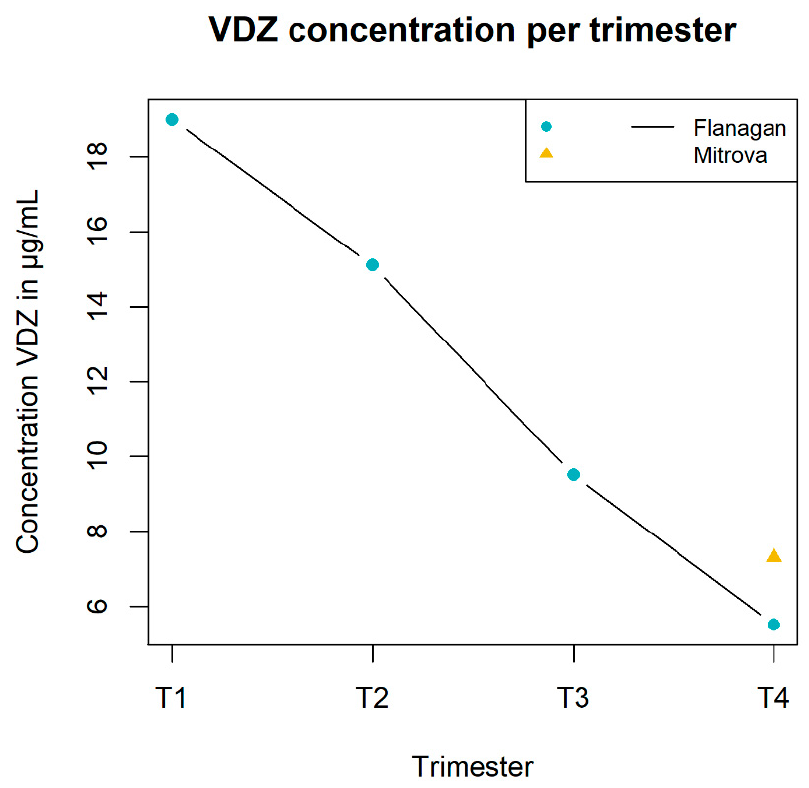
Figure 6. The concentrations of vedolizumab (VDZ) from all available studies [15,24] in µ g/mL (on the y -axis) during the different stages of pregnancy (on the x -axis). The different states are expressed as pre-pregnancy (T0), trimesters one until three (T1, T2 and T3) and delivery (T4). Flanagan et al. mentioned that no dose change was recommended for VDZ [15].